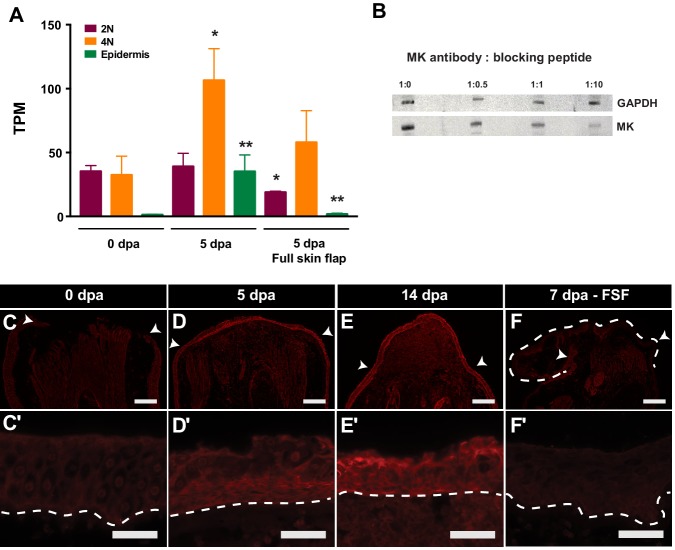
MK protein is found throughout the wound epidermis/AEC.(A) Normalized TPM levels of midkine (mk) in regenerating and full skin flap conditions. (B) Validation of custom polyclonal rabbit anti-MK antibody. Western blotting was performed with increasing volumetric ratios of MK antibody: blocking peptide ratios on 10 dpa protein extracts and revealed lower levels of staining with increased levels of peptide. (C–F’) Immunostaining of axolotl MK protein at 0 (C–C’), 5 (D–D’) and 14 dpa (E–E’). White arrowheads denote the amputation plane. Higher 20x magnification images of the wound epidermis or AEC (14 dpa) are shown in C’-F’. (F–F’) Immunostaining of axolotl MK protein in full skin flap sutured limbs at 7 dpa reveals lower levels of expression. Dotted lines demarcate full skin flap in F and the wound epidermis/stump boundary in C’-F’. Graphs are mean ± SD. **p<0.005, *p<0.05. Scale bars, B, E-H: 500 µm, E’-H’: 100 µm. FSF, full skin flap; dpa, days post-amputation.